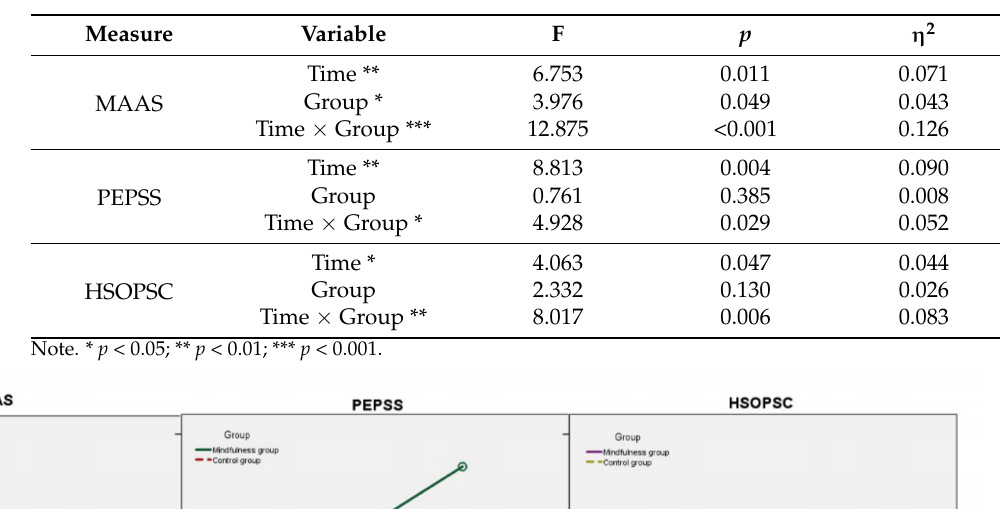
Table 3. ANOVA Results.